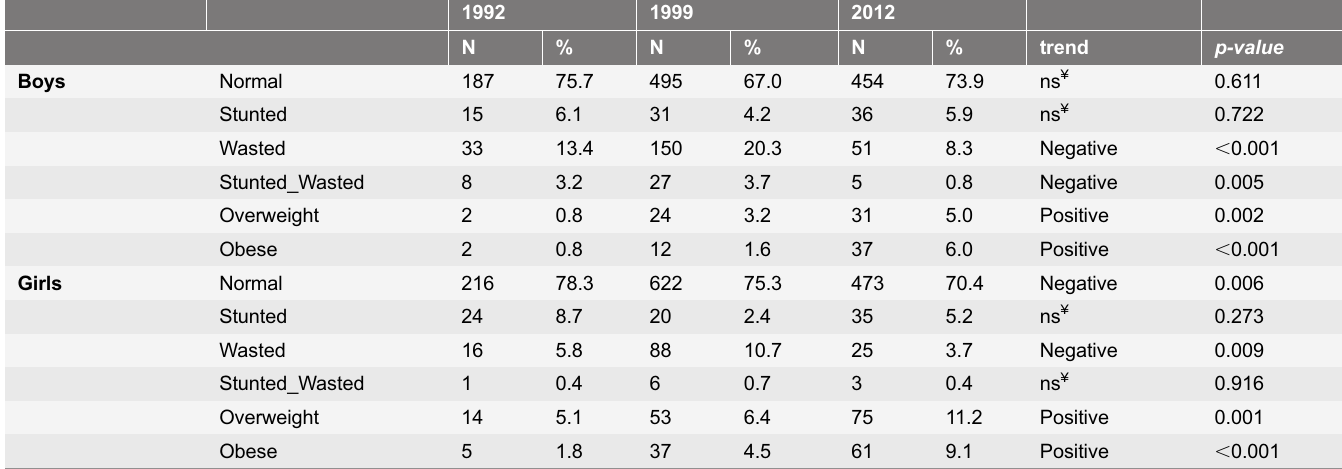
Table 5. Prevalence of nutritional status by sex and years of evaluation, and differences in prevalence between the years of evaluation by